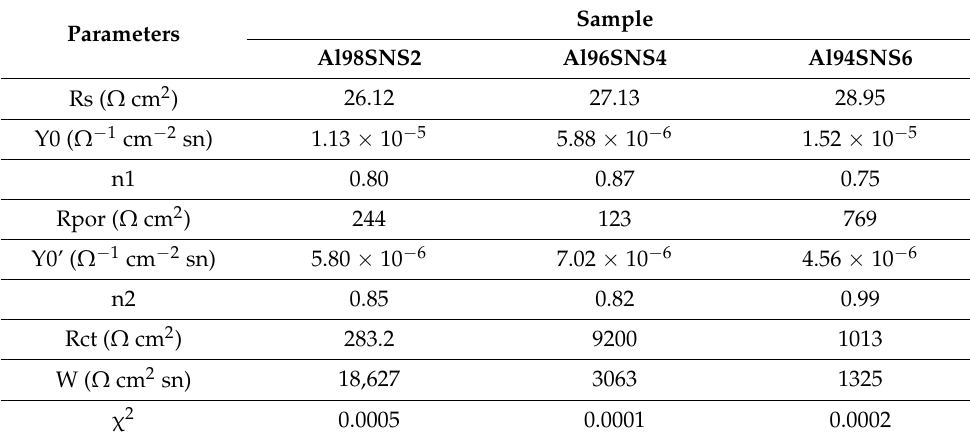
Table 6. The fitting results of EIS data for the investigated